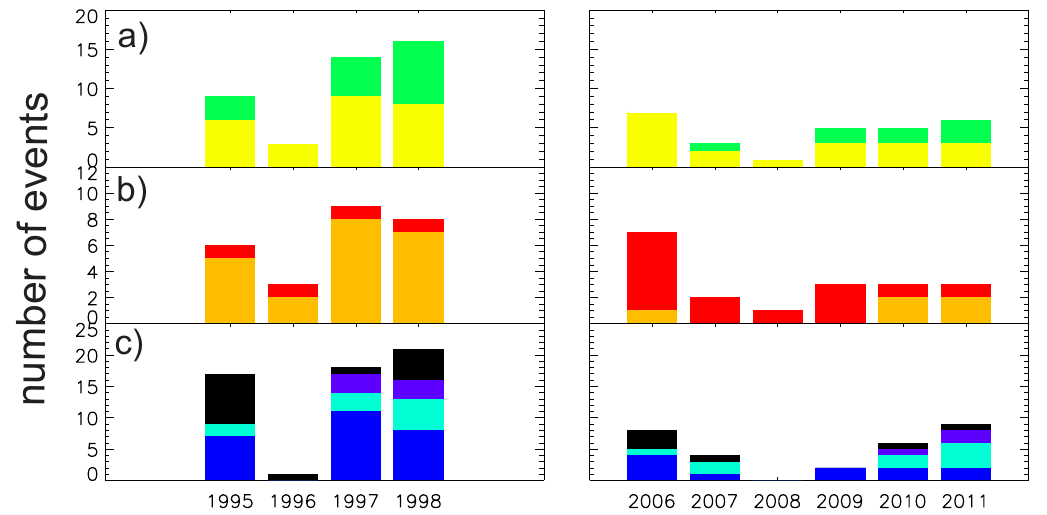
Fig. 3. Stacked histograms show annual counts of (a) bipolar (yellow bars) and unipolar (green bars) clouds, (b) original-SN (orange bars) and original-NS (red bars) clouds, (c) Dst < − 50nT magnetic storms as predicted from Eqs. (1)–(2) using measured B Z . In the bottom panel blue bars represent storms associated with magnetic clouds, light blue bars complex ICMEs, purple bars sheath regions and finally black bars give the number of storms related to non-CME solar